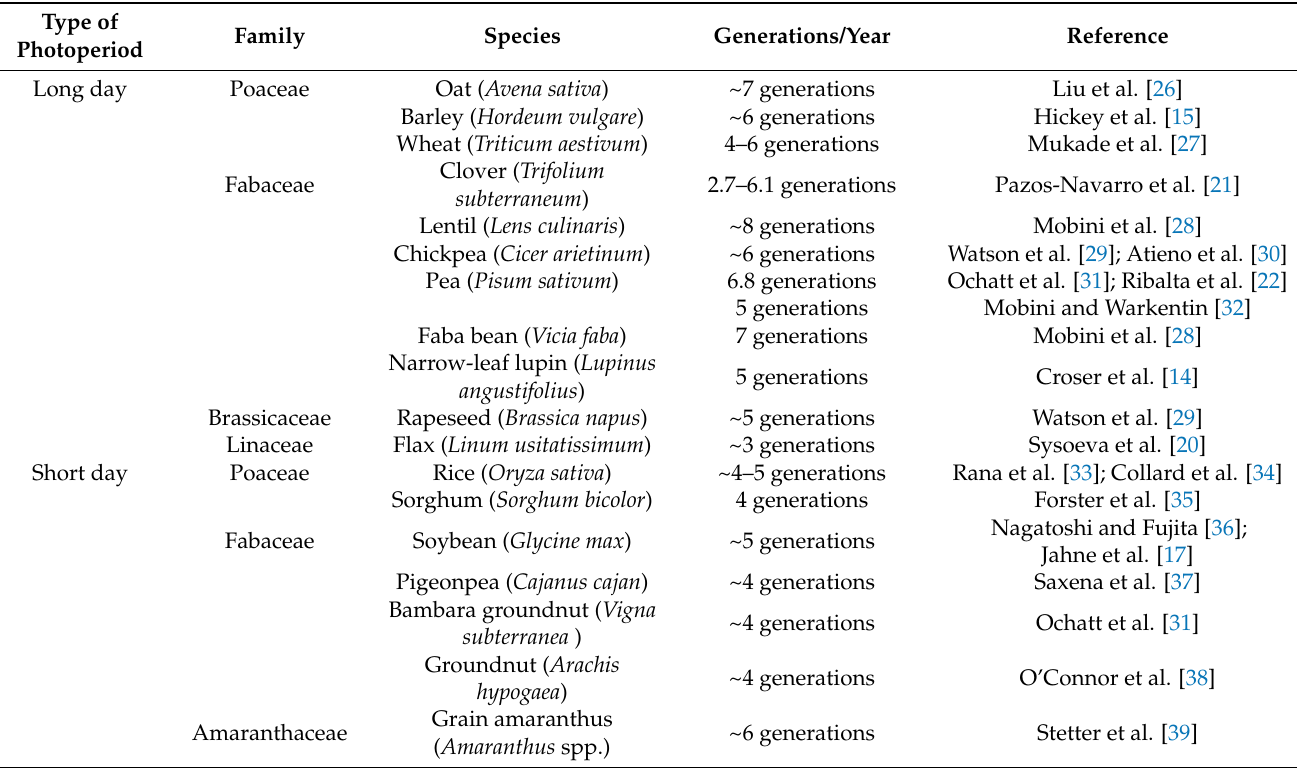
Table 1. List of crops where speed breeding has increased generation